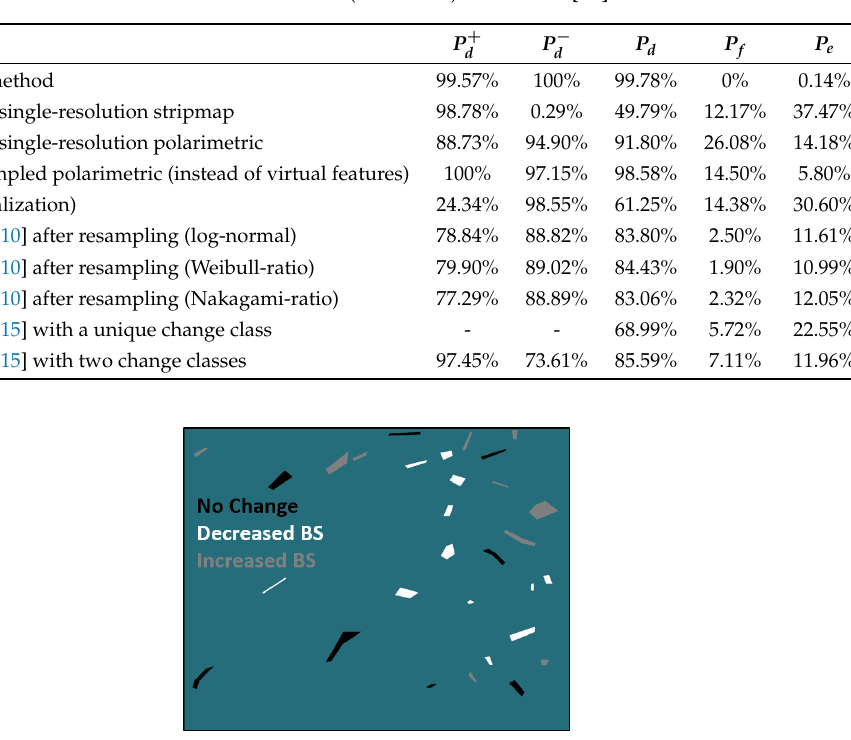
Figure 5. ROC curves of the method in [27] applied after upsampling the polarimetric channels to the resolution of the stripmap data. The curves were obtained by operating either with the original data or after despeckling with a 7 × 7 or a 15 × 15 GammaMAP filter. For comparison purposes, the plot also shows the ( P f , P d ) point obtained by the proposed method. Table 1. Performances estimated on the test set: (1) detection probability for the change class associated with increased backscattering coefficient ( P + ), (2) detection probability for the change class associated d with decreased backscattering coefficient ( P − ), (3) overall detection probability ( P d ), (4) false alarm d probability ( P f ) and (5) error probability ( P e ). The results obtained by the proposed method are compared with those of its single-resolution versions, its initialization (i.e., the generalized Kittler and Illingworth thresholding (GKIT) algorithm), its variant in which the virtual features were replaced by the log-ratios of the resampled polarimetric channels, the MRF-based method in [10] and the multiscale fusion at the decision level on all reliable scales (FDL-ARS) method in [15].